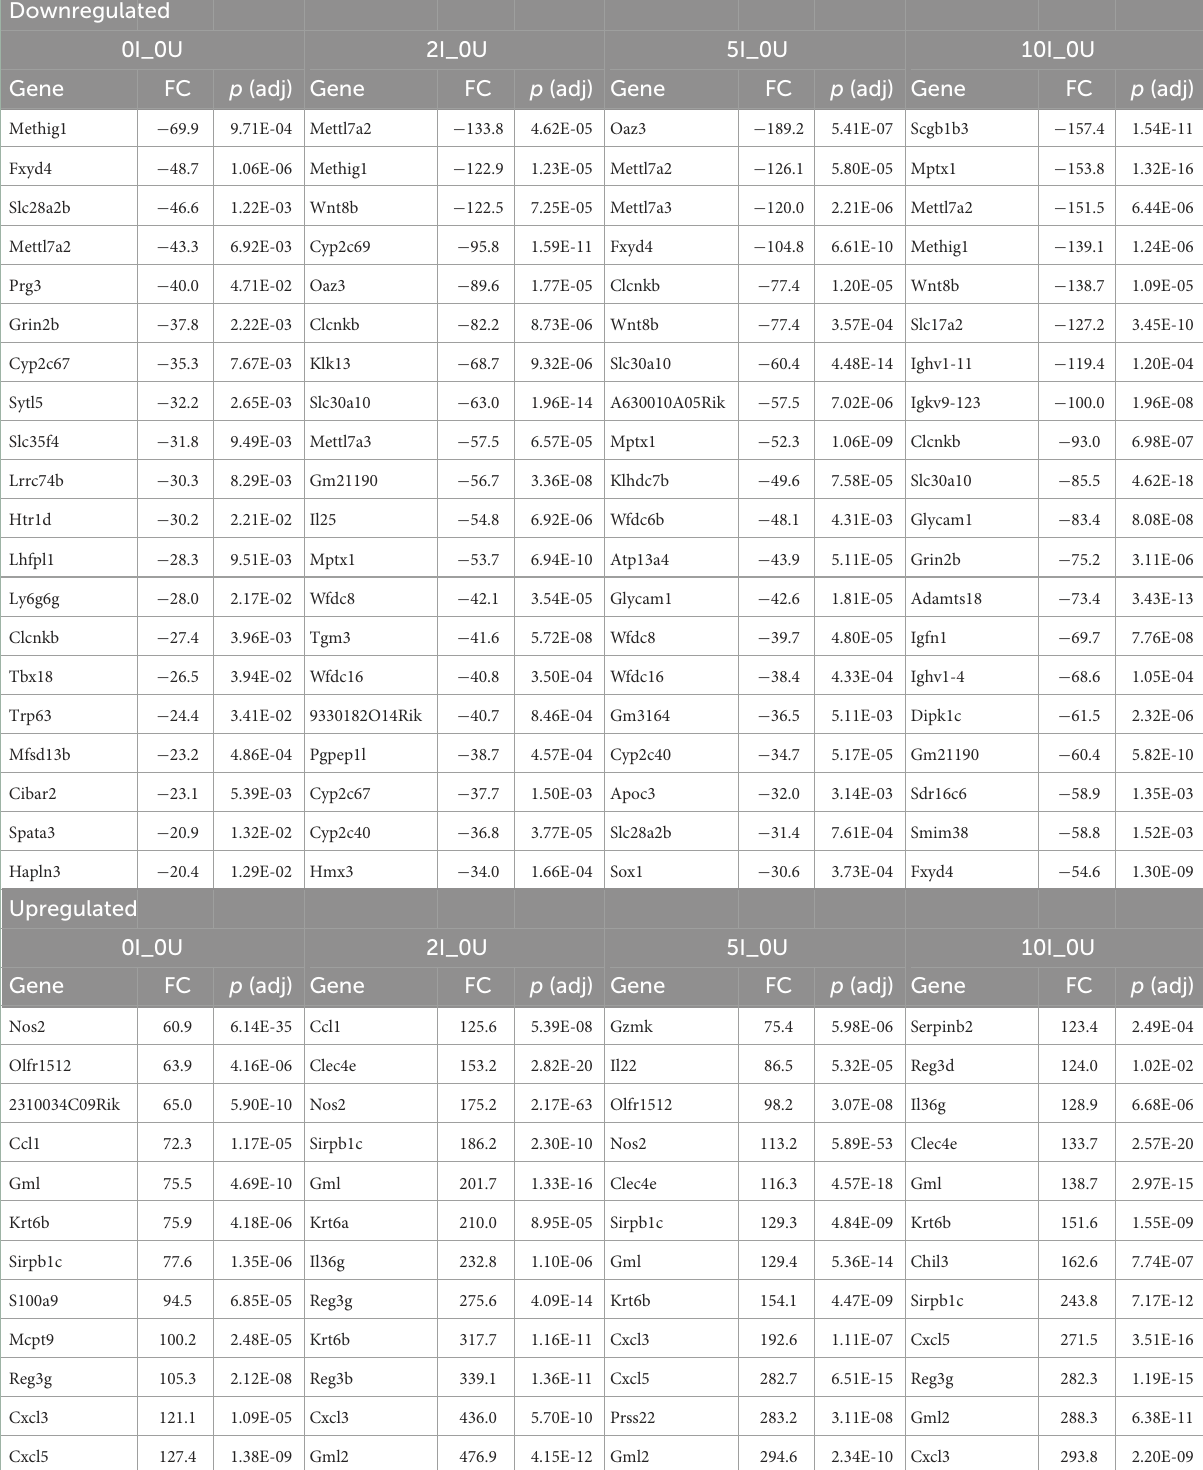
TABLE 4 Top 20 differentially expressed genes in the infected distal colon.